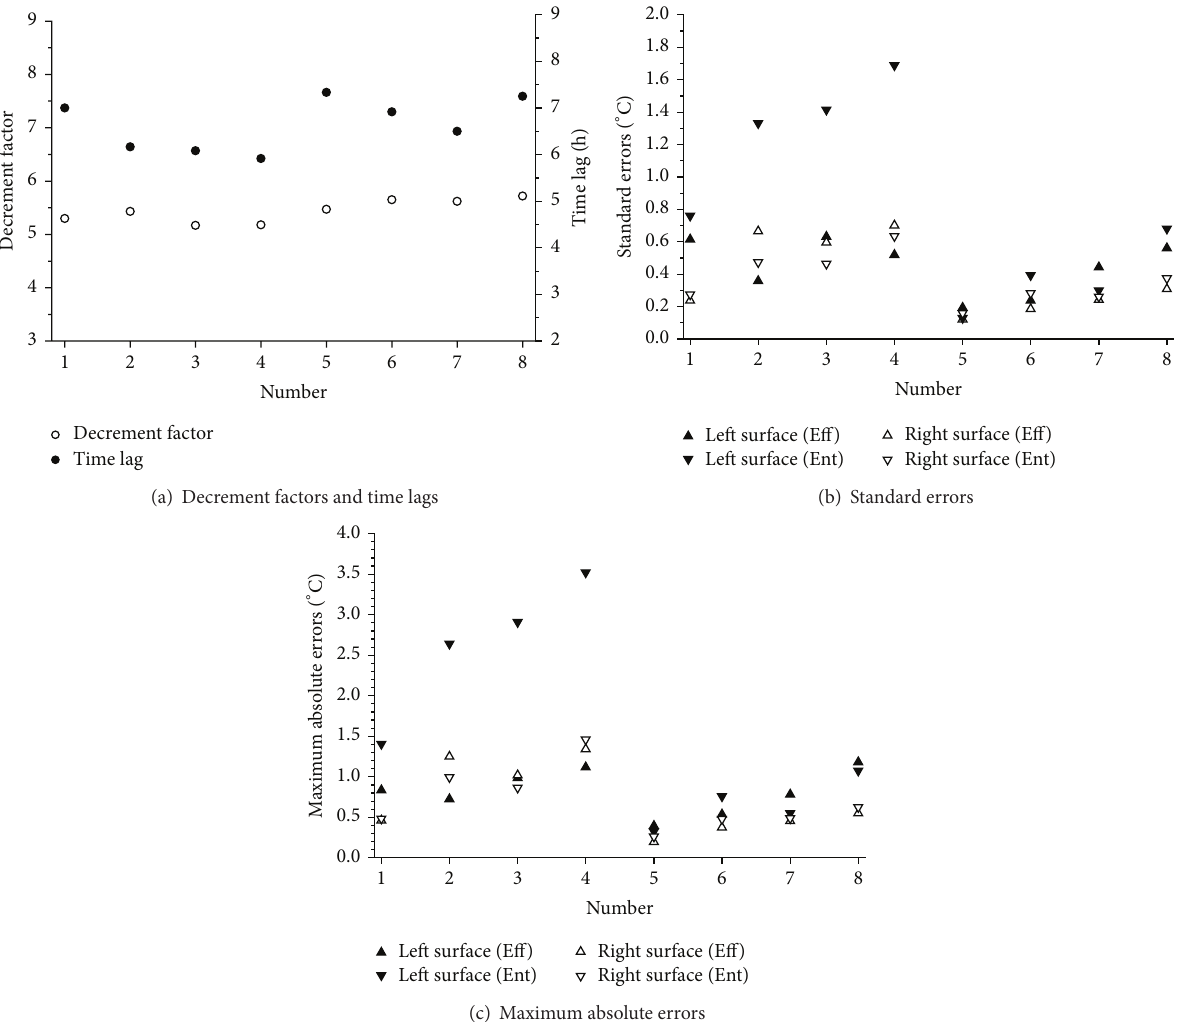
Figure 5: Experimental data of Block 2 wall and calculation